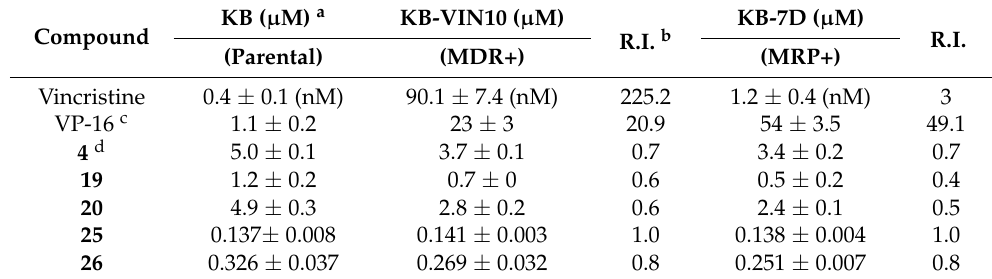
Table 2. Growth inhibition of salvinal derivatives against KB-derived resistance cancer cell lines.